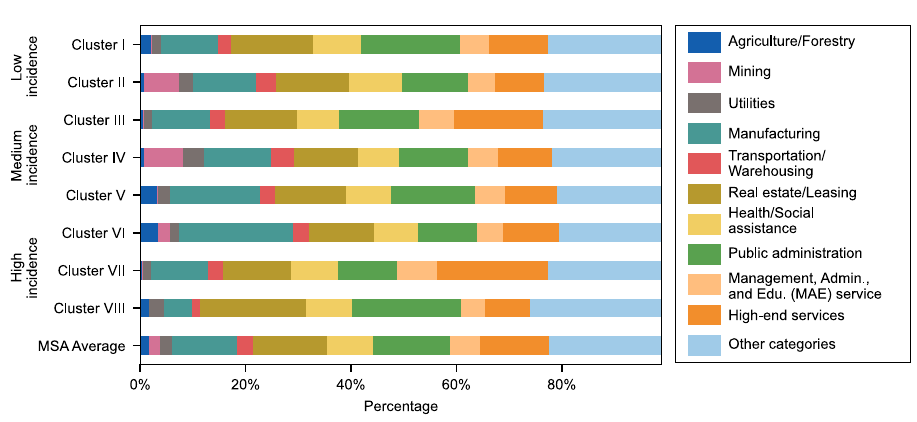
Fig. 2 | Cluster centers of MSA economic structure. The length of each colored bar represents the GDP percentage of the corresponding economic